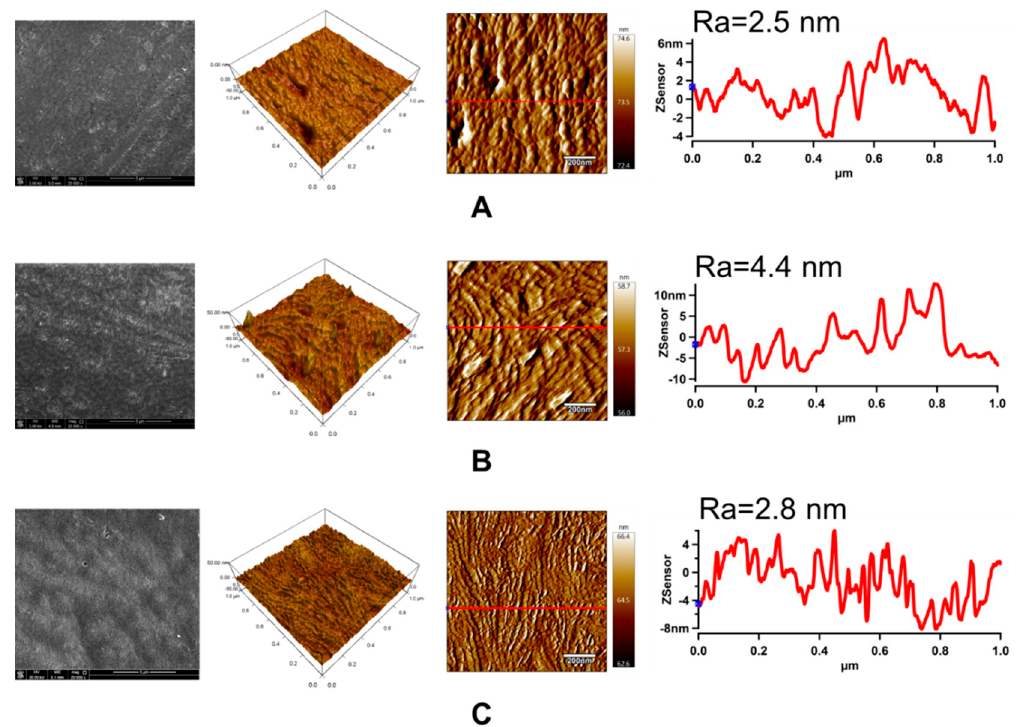
Figure 8. Scanning electron microscopy (SEM), 3D height. and amplitude atomic force microscopy (AFM) images with line profiles (Z-sensor) of LDPE: ( A ) untreated; ( B ) plasma-treated; ( C ) ASA-grafted. Note: Ra represents the roughness parameter.